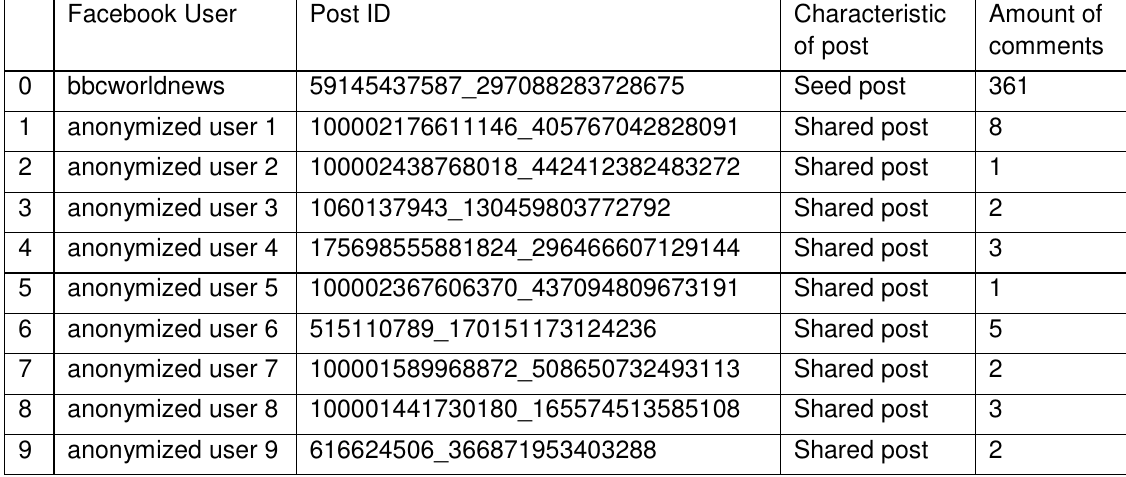
Table 1: Facebook Users who shared a seed post and aggregated comments on their shares